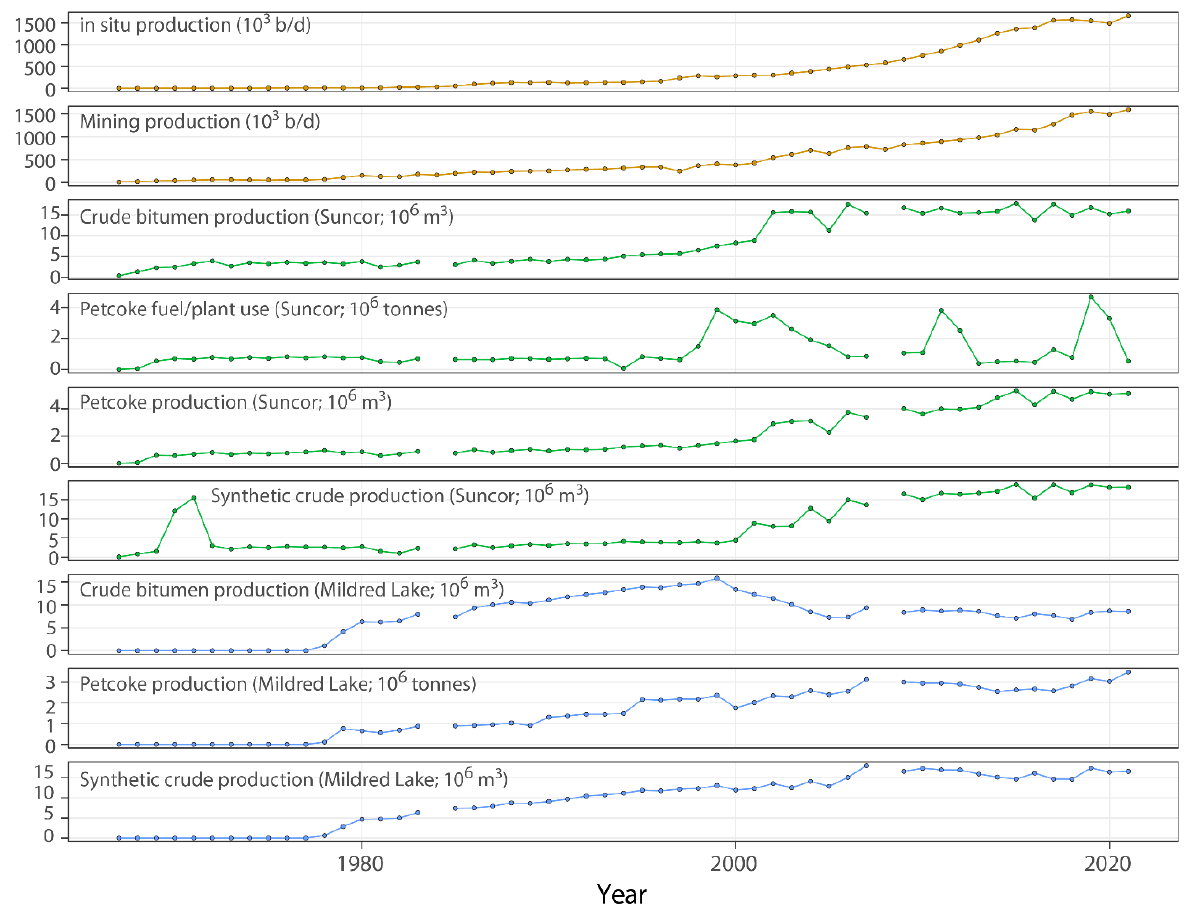
Figure 4. Annual production for in situ and mining sectors along with and performance metrics from Suncor Basemine (Suncor) and Syncrude Mildred Lake from 1967 to 2021; facility-specific performance data from 1984 and 2008 not available.